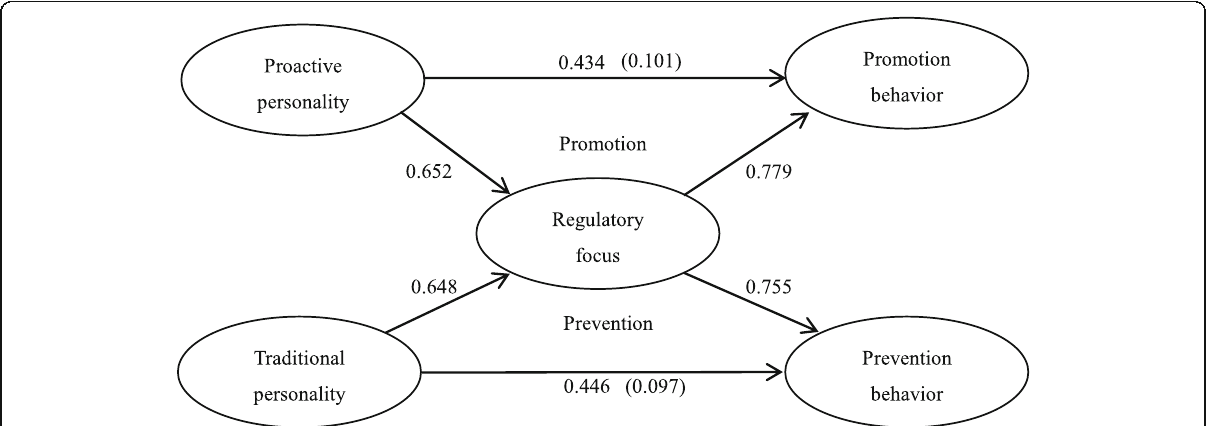
Fig. 2 Regulatory focus as the mediator variable ’ s influence path. Note that data in () is the direct influence coefficient of the independent variable on the dependent variable after adding mediation